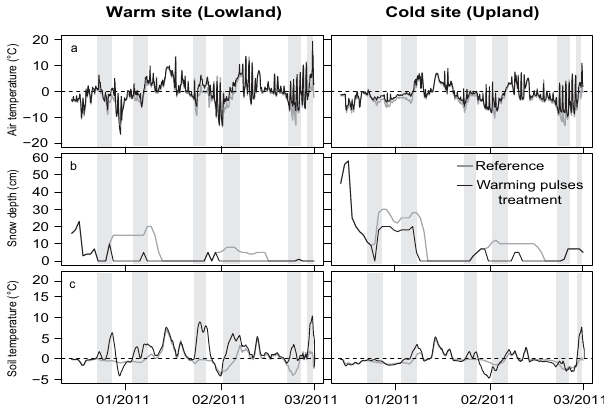
Figure 1. Mean daily air temperature at + 5cm (a) , snow depth (b) and mean daily soil temperature at − 2cm (c) at the two experimen- tal sites for the winter warming pulses treatment (black line) and reference conditions (grey line). Warming pulses (grey boxes) were applied between 15 December 2010 and 28 February 2011 (Schuer- ings et al.,